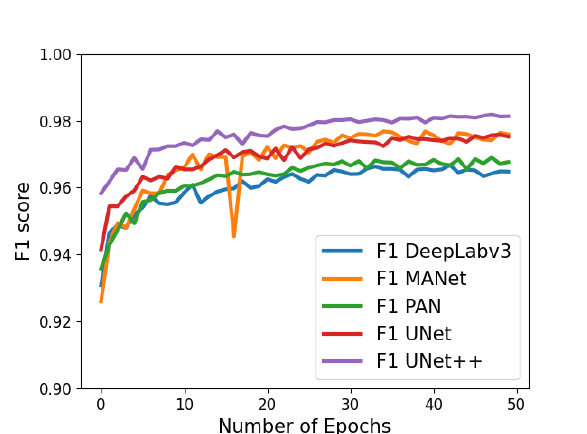
Figure 10 . F1 score for training with ResNet50 with different DL-CNNs. DeepLabV3(blue), MANet(orange), PAN(green), UNet(red), UNet++(purple)